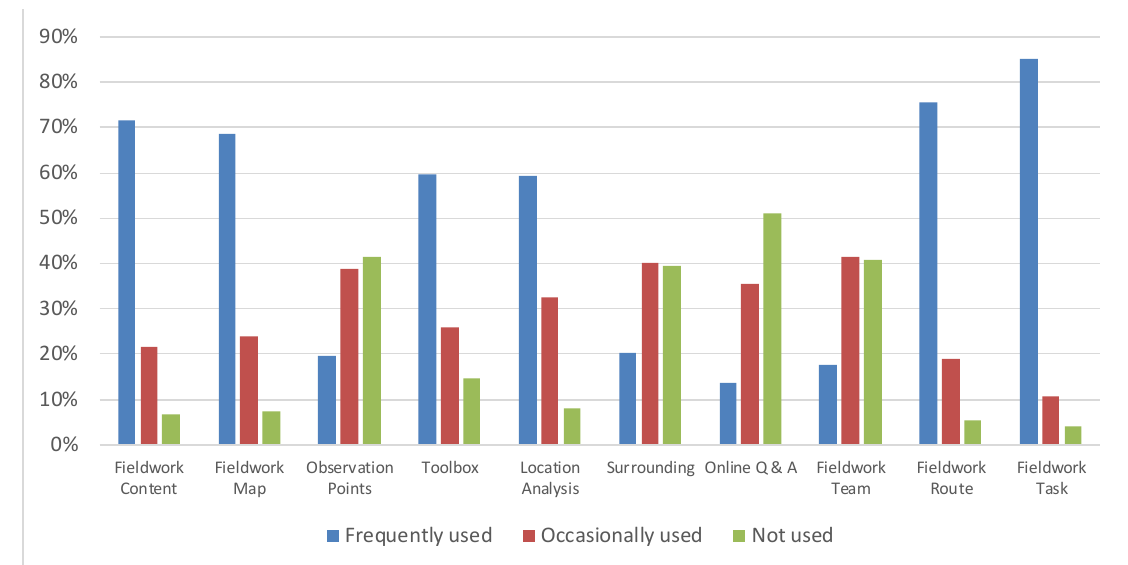
Figure 7. The usage of common functional modules in the whole process of the fieldwork.